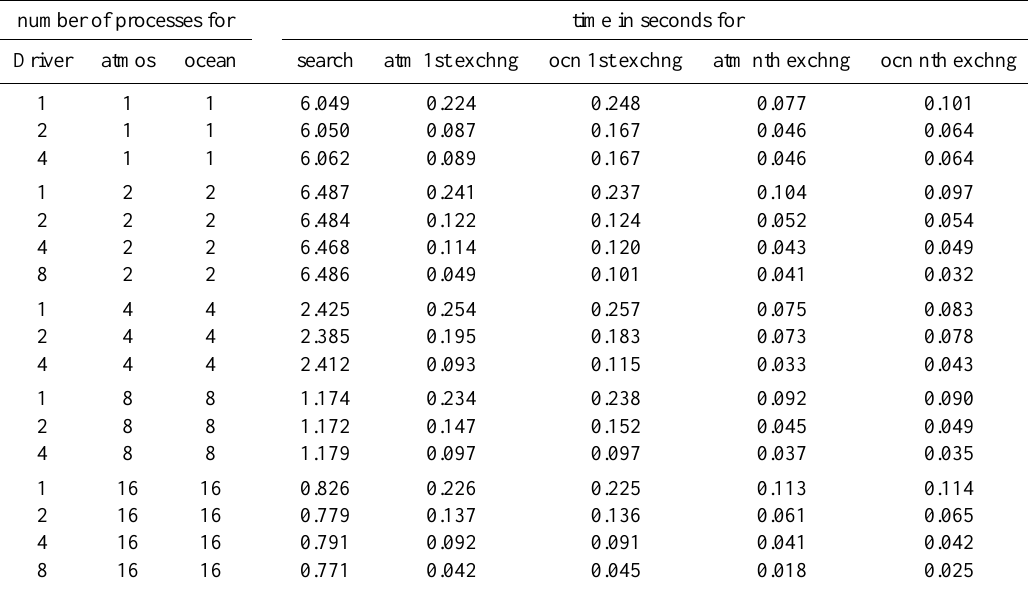
Table 2. Performance of OASIS4 tasks obained on a PC cluster for 2-D search. number of processes for time in seconds